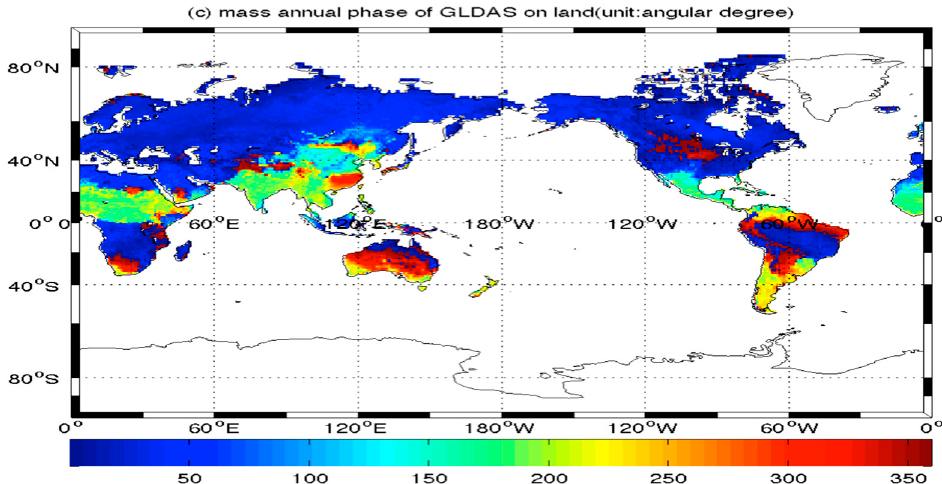
Figure 8. Annual phases of terrestrial water storage of GPS+SA and GRACE and GLDAS (unit: mm) using ten years of data from 2003 to 2012. Atmosphere and ocean mass variations are removed with the GRACE in-situ product. ( a – c ) are results of GPS+SA, GRACE RL05 and GLDAS respectively.